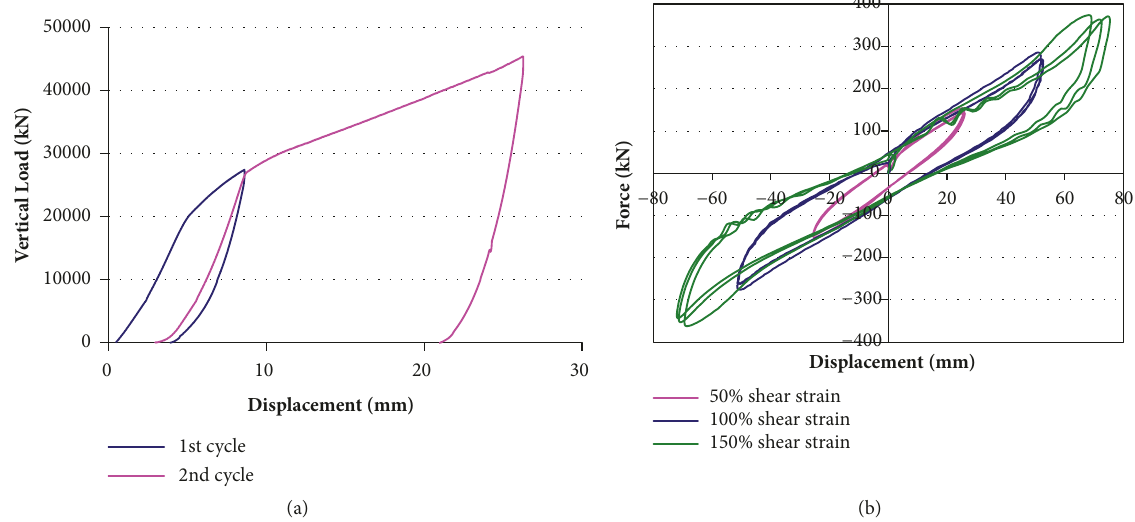
Figure 6: Static and dynamic behaviour of specimen under vertical (a) and horizontal force (b) for different shear strain.